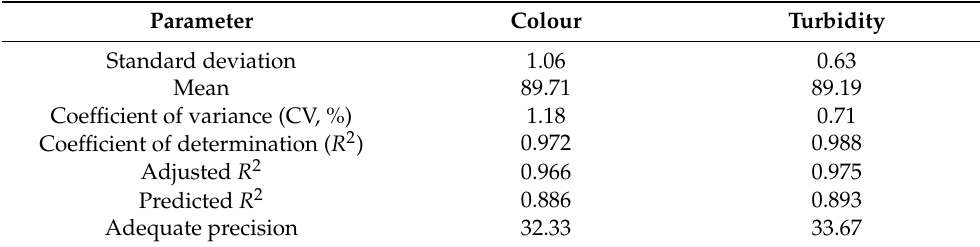
Table 3. Analysis of variance (ANOVA) results for the response quadratic models.